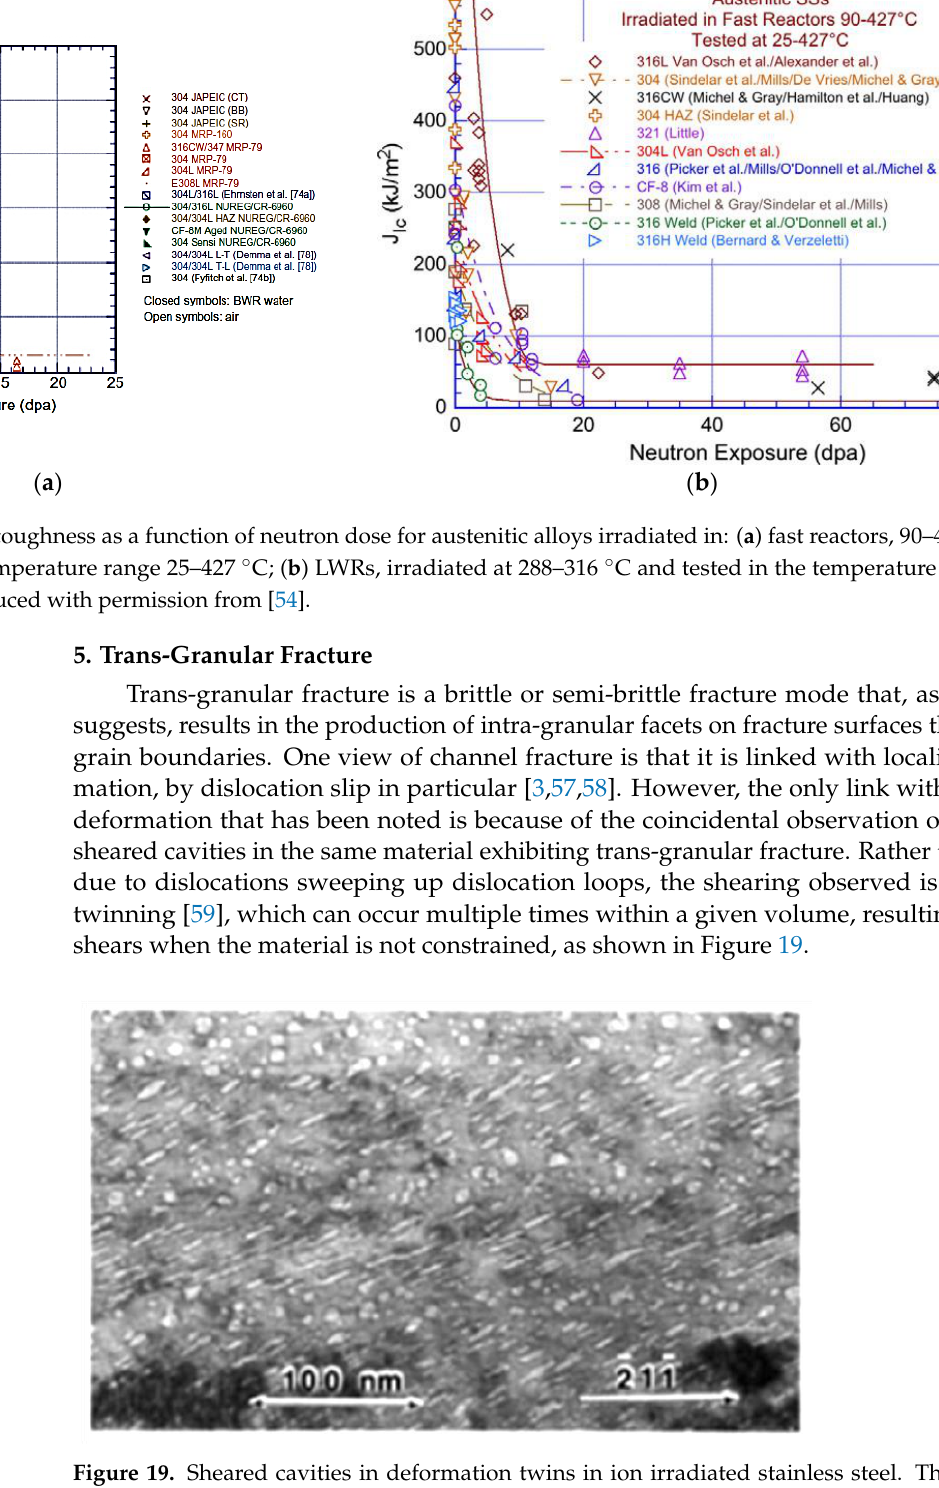
Figure 19. Sheared cavities in deformation twins in ion irradiated stainless steel. The twinning direction is 2 ̅ 11 ̅ as indicated on the micrograph. Reproduced with permission from [59].